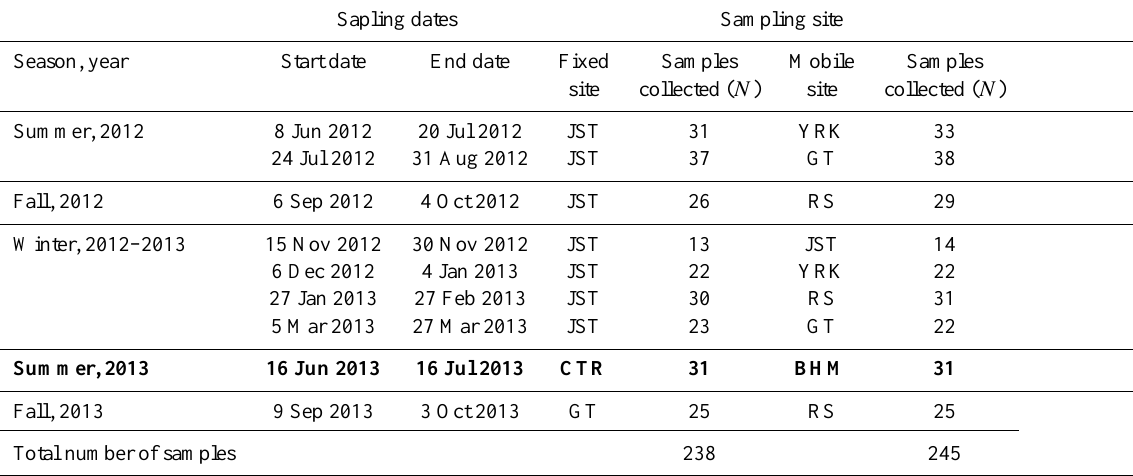
Table 1. Sampling plan and details of sampling dates at each site.